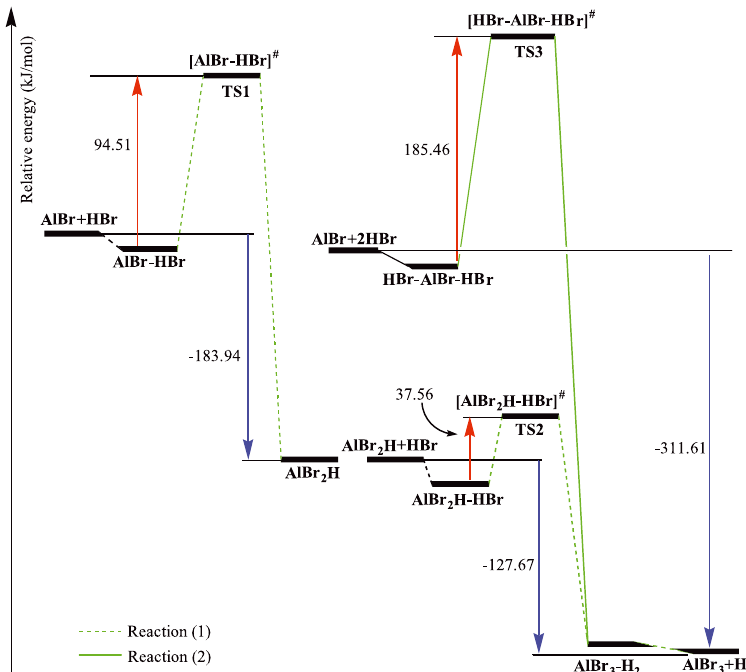
Figure 5. Potential energy surface, reaction energies (kJ mol -1 ) and activation barrier energies (kJ mol -1 ) for reaction between AlBr and HBr.